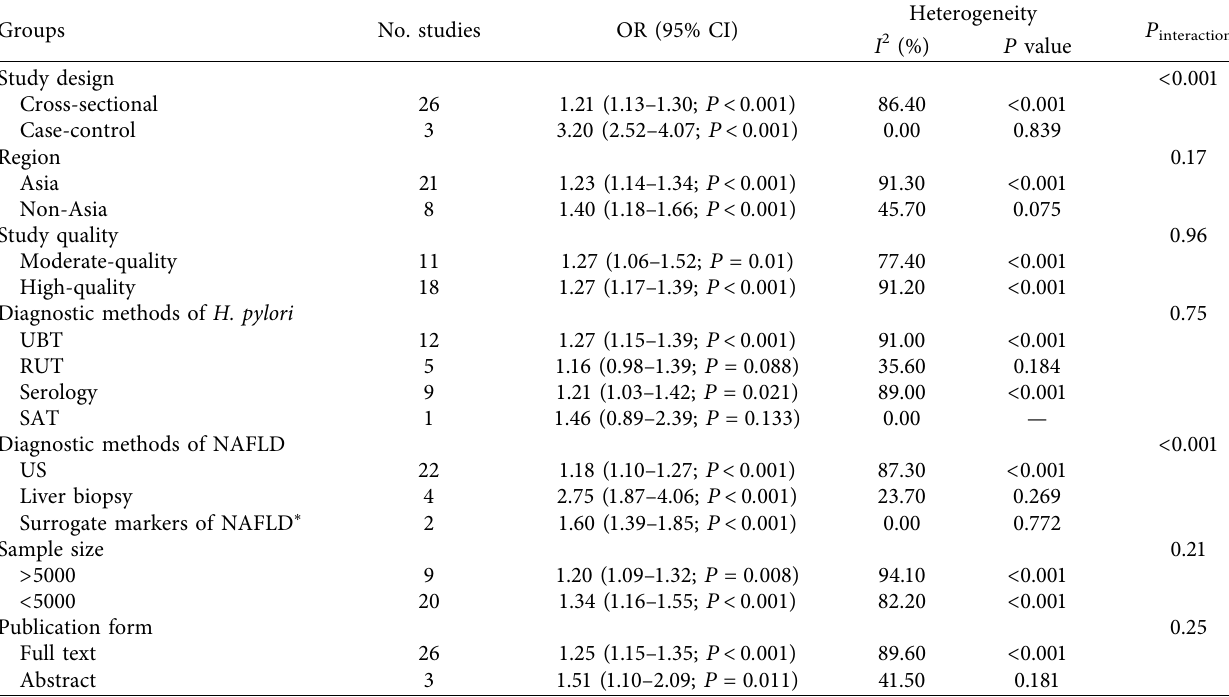
Table 2: Meta-analysis regarding the association of H. pylori infection with NAFLD in studies unadjusted for confounders.